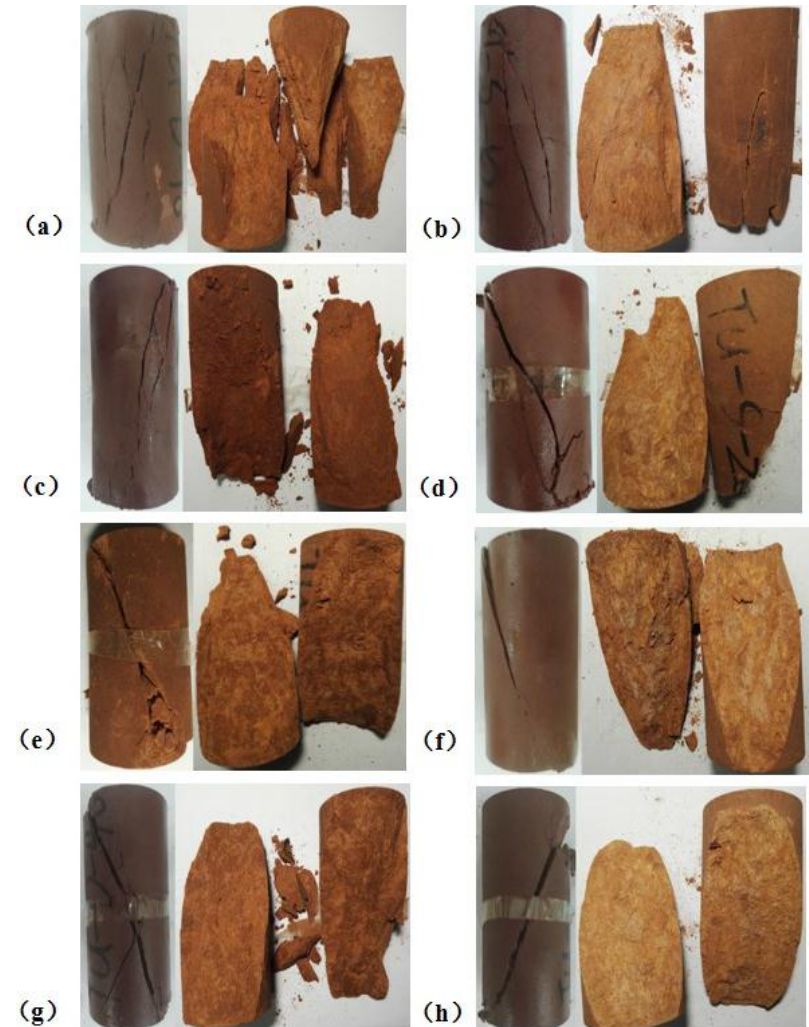
Figure 6. Failure modes of dry and saturated sandstones in unloading confining pressure tests: ( a ) TU-D-10; ( b ) TU-S-10; ( c ) TU-D-20; ( d ) TU-S-20; ( e ) TU-D-30; ( f ) TU-S-30; ( g ) TU-D-40; ( h ) TU-S-40.